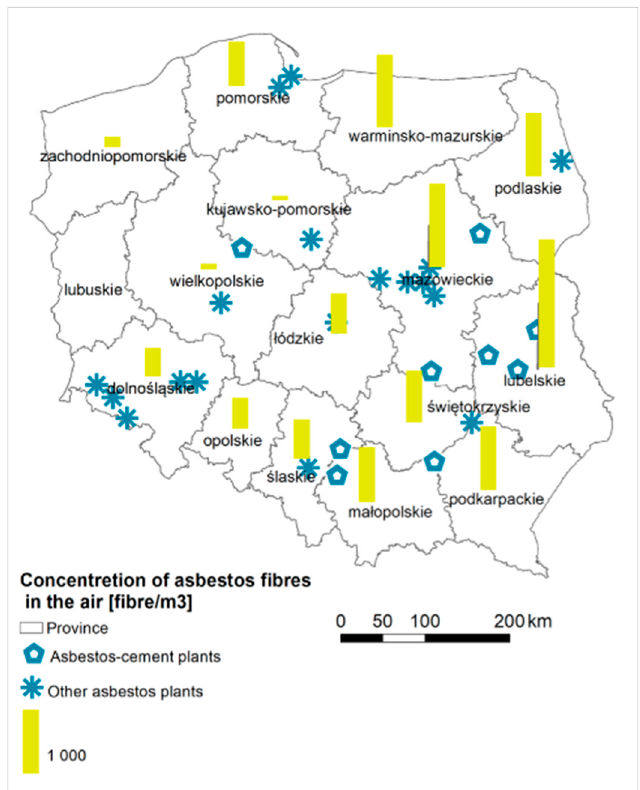
Figure 3. Measurements of concentrations of asbestos fibers in the air in relation to asbestos manufacturing plants in Poland.